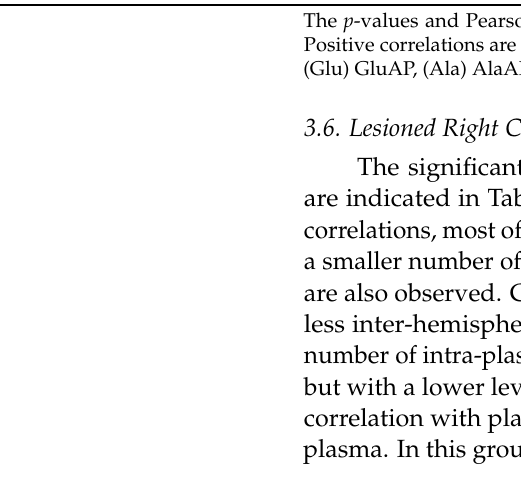
LPAla vs. PlAla r = +0.706 p = 0.02 LACys vs. PlGlu r = +0.703 p = 0.02